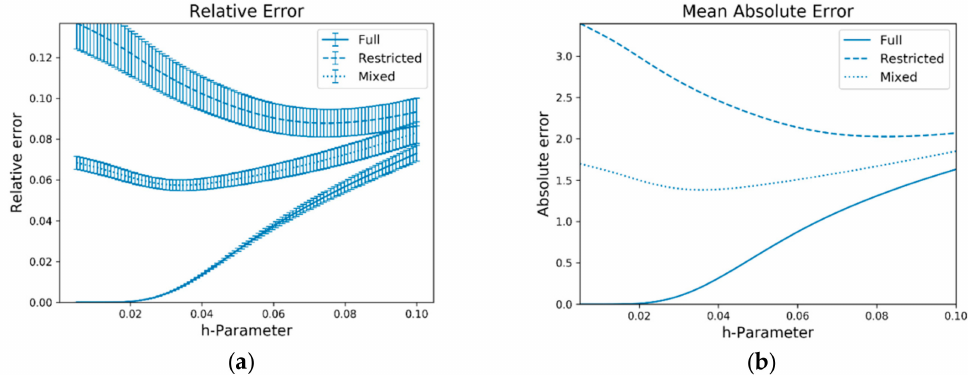
Figure 12. Results of the Heating load (reduced variable set) problem for the full, restricted and mixed models with the parameter selection h = ω . ( a ) MAPE depending on h ; ( b ) MAE depending on h .